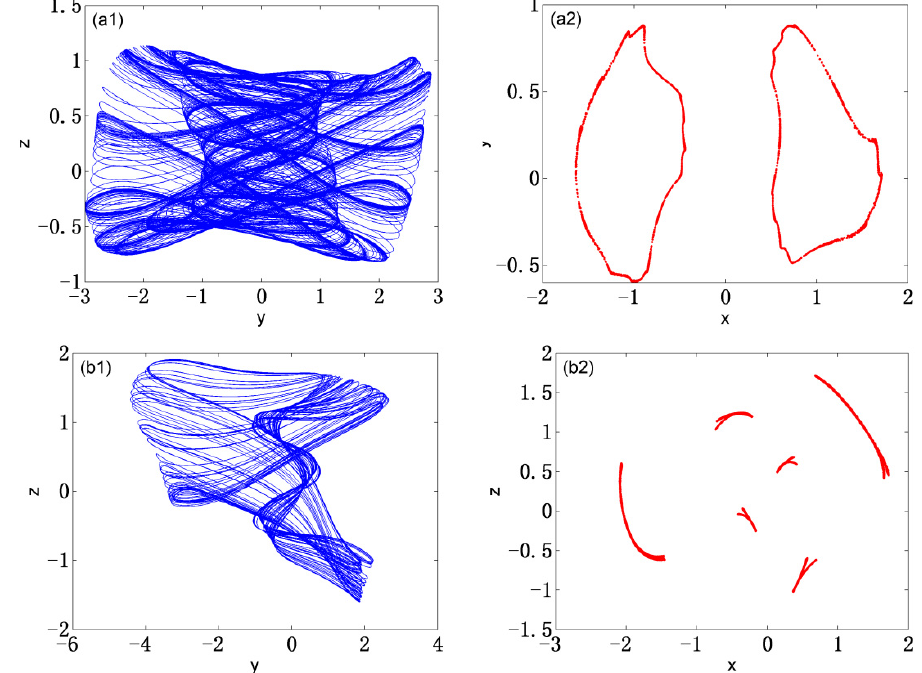
Figure 12. Coexistence of hidden quasi-periodic and chaotic attractor for different initial values. ( a1 , a2 ) are phase trajectory and Poincare maps with initial value (0, 2, 0, 0), respectively. ( b1 , b2 ) are phase trajectory and Poincare maps with initial value (1, − 2, 0, 0), respectively.